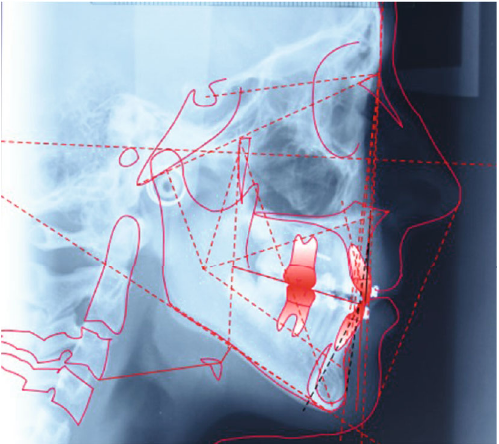
Figure 9: Final lateral